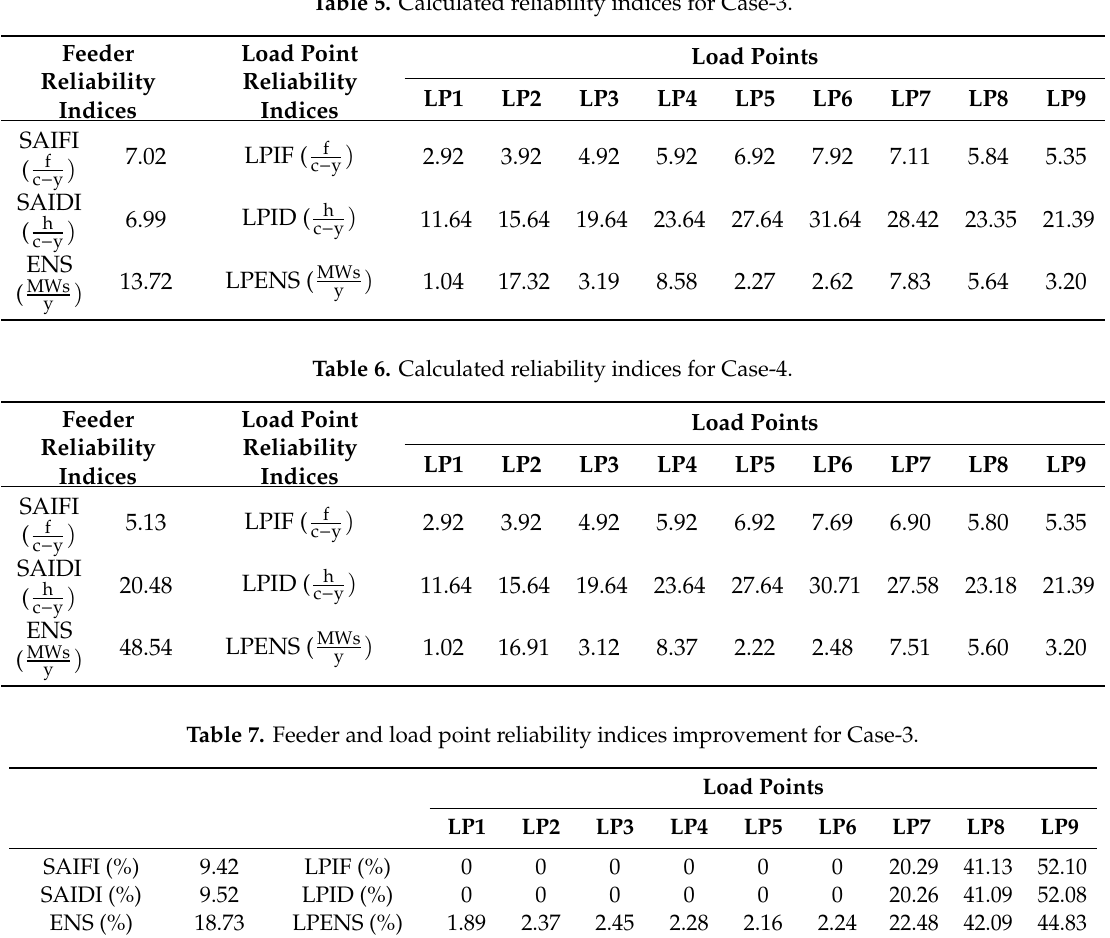
Table 5. Calculated reliability indices for Case-3.